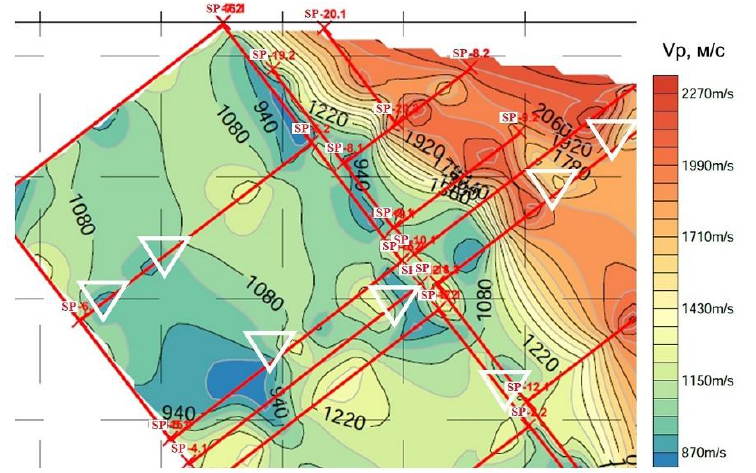
Figure 7. Fragment of the velocity model of P-wave propagation to the depth of about 20 m. Red lines mark the seismic profiles. White triangles are PES areas (according to Figure 6c). The area of scalar field of P-wave velocity coincides with the area of leading forecast in Figure 5c.